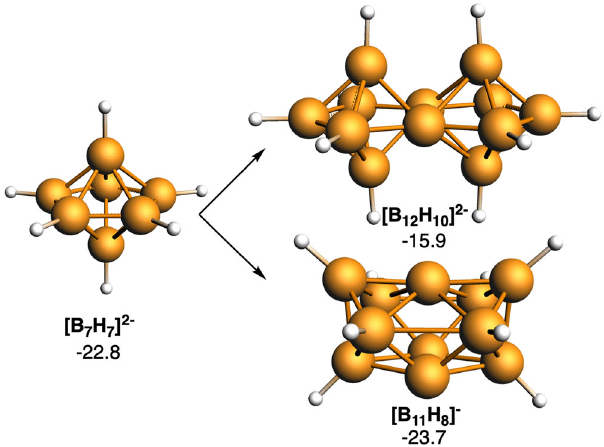
Fig. 1 3D/3D systems formed from [B 7 H 7 ] 2 − . Computed NICS (in ppm) at the center of the fi ve-membered ring of each cluster are enclosed. Boron atoms in orange and H atoms in